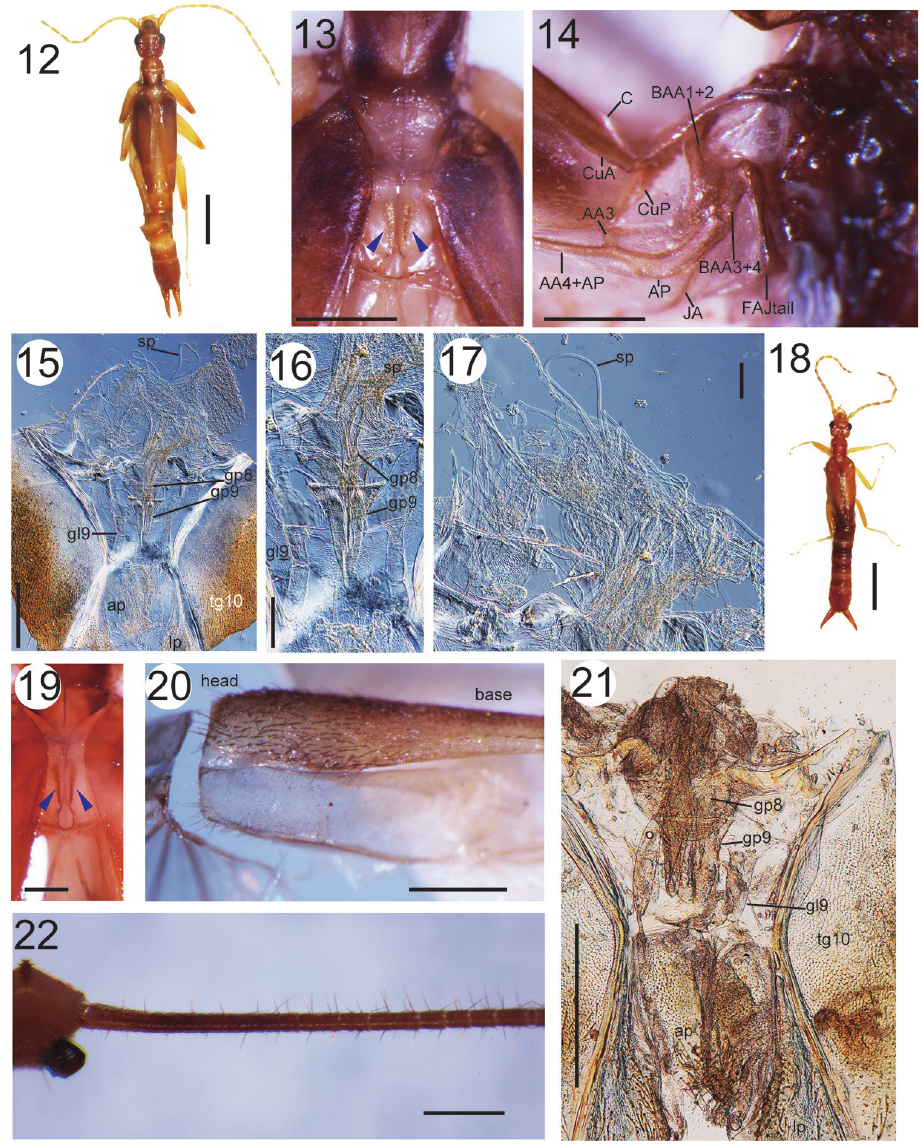
Figures 12–22. 12–17 Cylindrogaster sp. 1 (female): habitus ( 12 ), spiny ridges (indicated by the blue arrowheads) on the mesothorax ( 13 ), wing base of the left hindwing ( 14 ), and genital regions ( 15–17 ) 18–21 Cylindrogaster sp. 2 (female): habitus ( 18 ), spiny ridges (indicated by the blue arrowheads) on the mesothorax ( 19 ), fustis of the left hindwing ( 20 ), and genital regions ( 21 ) 22 Cylindrogaster sp. (nymph): detail of cercus. Scale bars 3 mm for Figs 12, 18 ; 0.5 mm for Figs 13–15, 19–22 ; 200 μm for Figs 16, 17